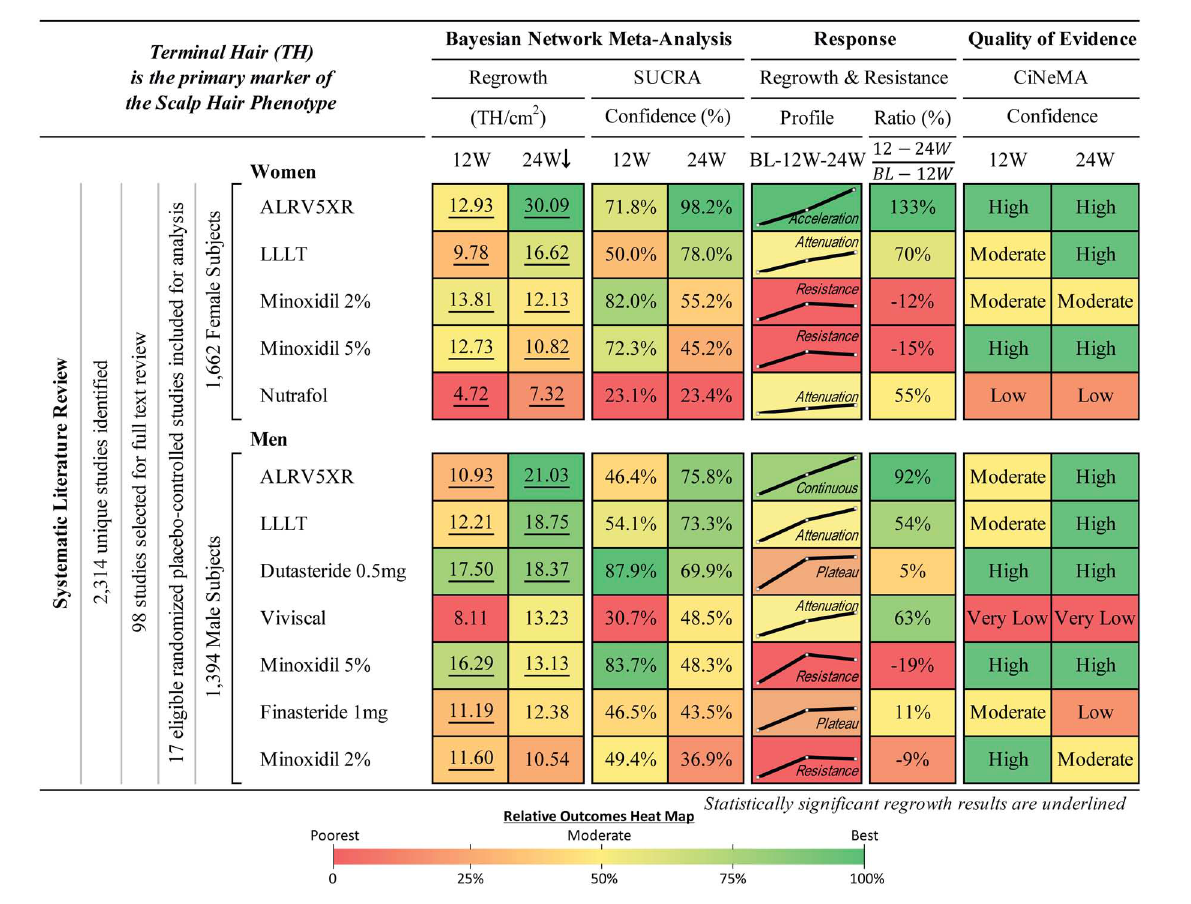
GRAPHICALABSTRACT Hair regrowth treatment efficacy and resistance in androgenetic alopecia. Systematic literature review and Bayesian network meta-analysis of terminal hair regrowth efficacy and resistance in women and men with androgenetic alopecia using different treatments vs. Placebo at 12 and 24 weeks. Women and men are listed in descending order of efficacy at 24 weeks of network meta-analysis (NMA) after 250,000 Markov Chain Monte Carlo simulations. Regrowth measures efficacy as mean difference (MD) in TH/cm 2 between each treatment and Placebo using direct and indirect comparisons. 12 and 24W refer to 12 and 24 week treatment duration. SUCRA: surface under the cumulative ranking area measures relative confidence. Response Profile is a line graph connecting the treatment changes from baseline (BL) to MD at 12 and 24W. Y-axes (MD) are scaled 0–31 for women and 0–22 for men. Response Ratio (%) is change in regrowth of 12–24W compared to BL-12W. Quality of evidence is CiNeMA results using Cochrane risk of bias, GRADE scores, and study data. Heat maps are shared between each sex’s numerical result block and manually assigned to categorical